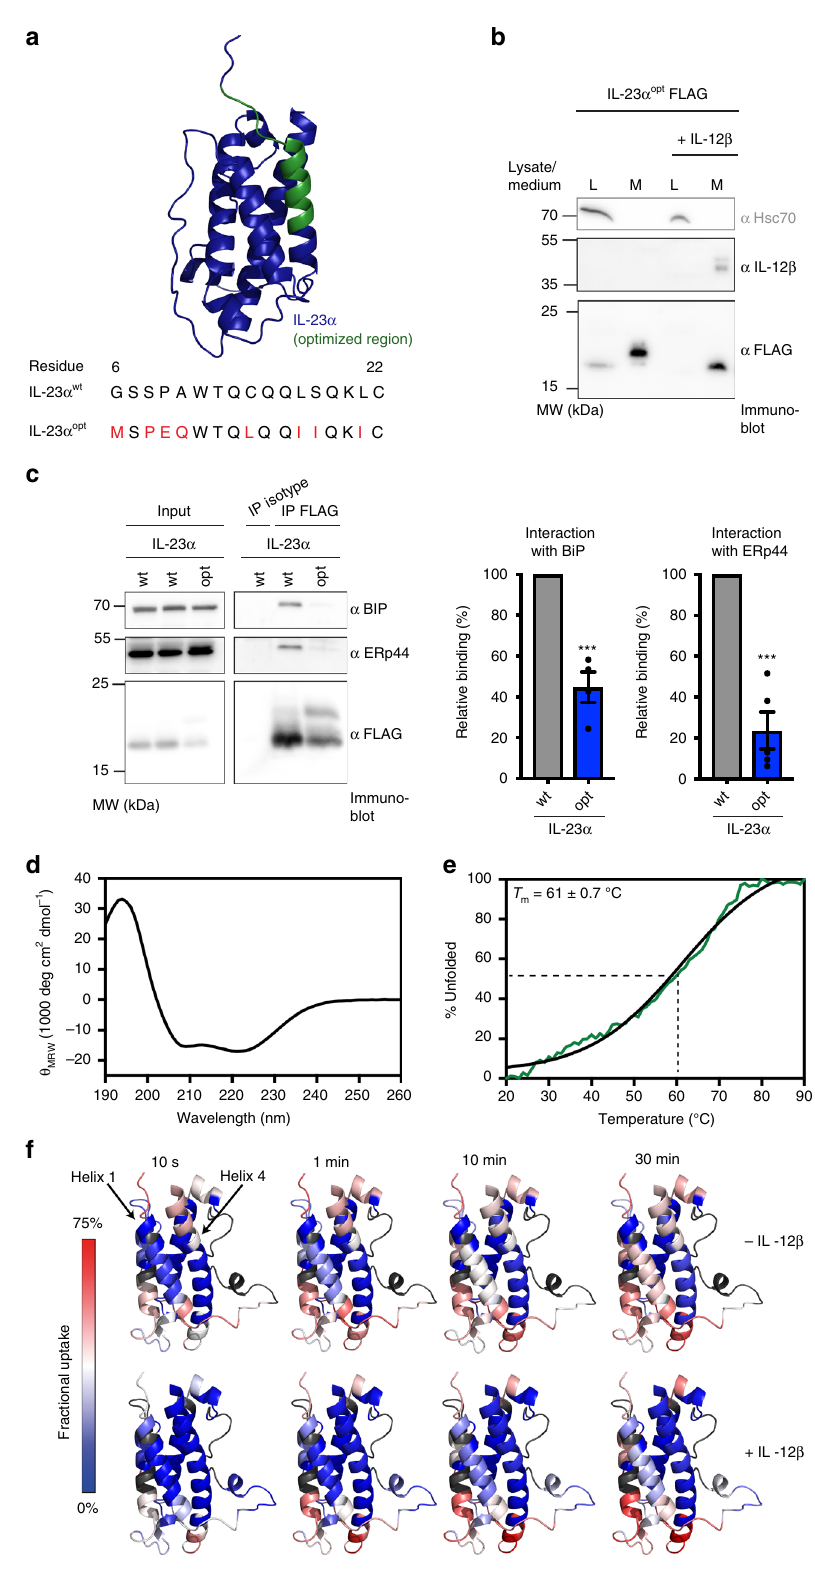
different stages of the secretory pathway. BiP is able to recognize hydrophobic stretches in partially unfolded proteins already as early as during co-translational import into the ER 36 – 38 , whereas ERp44 acts later inside the ER – Golgi intermediate compart- ment 39 , preventing secretion of unassembled or incorrectly folded proteins 31 . Our structural analyses combined with cellular